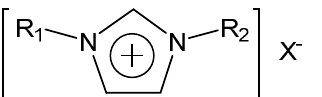
Figure 1. The generic structure of alkyl-substituted imidazolium=based ILs. R 1 = alkyl (methyl typically), R 2 = alkyl, X − = anion (halide, BF 4 − , PF 6 − , Tf 2 N − , typically).